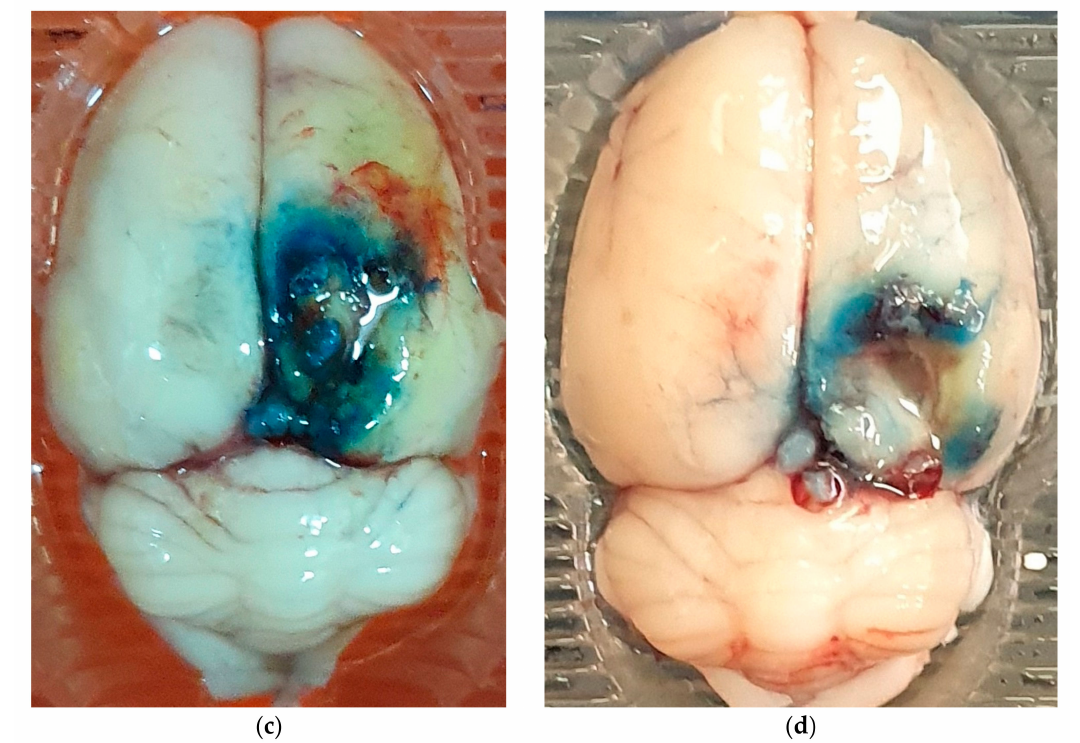
Figure 2. Representative morphological images for hyperosmolar and TBI-based BBB opening models. Injured hemisphere on the right side. ( a ) Representative image of the brain without BBB opening; ( b ) representative brain image for HOBBB model; ( c ) representative brain image for 6 h TBI-based BBB opening model; ( d ) representative brain image for 24 h TBI-based BBB opening